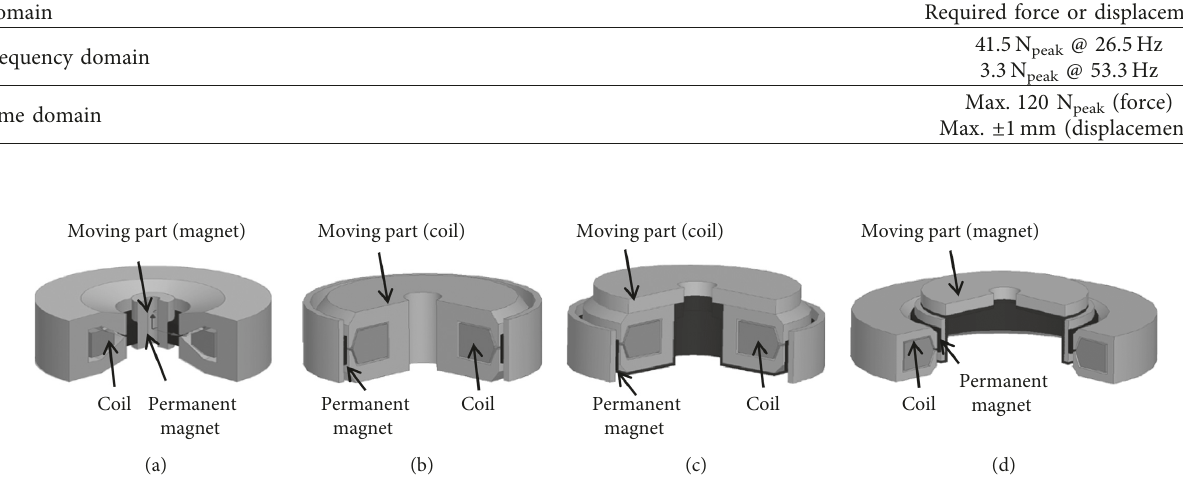
Table 1: Required design specification of the electromagnetic